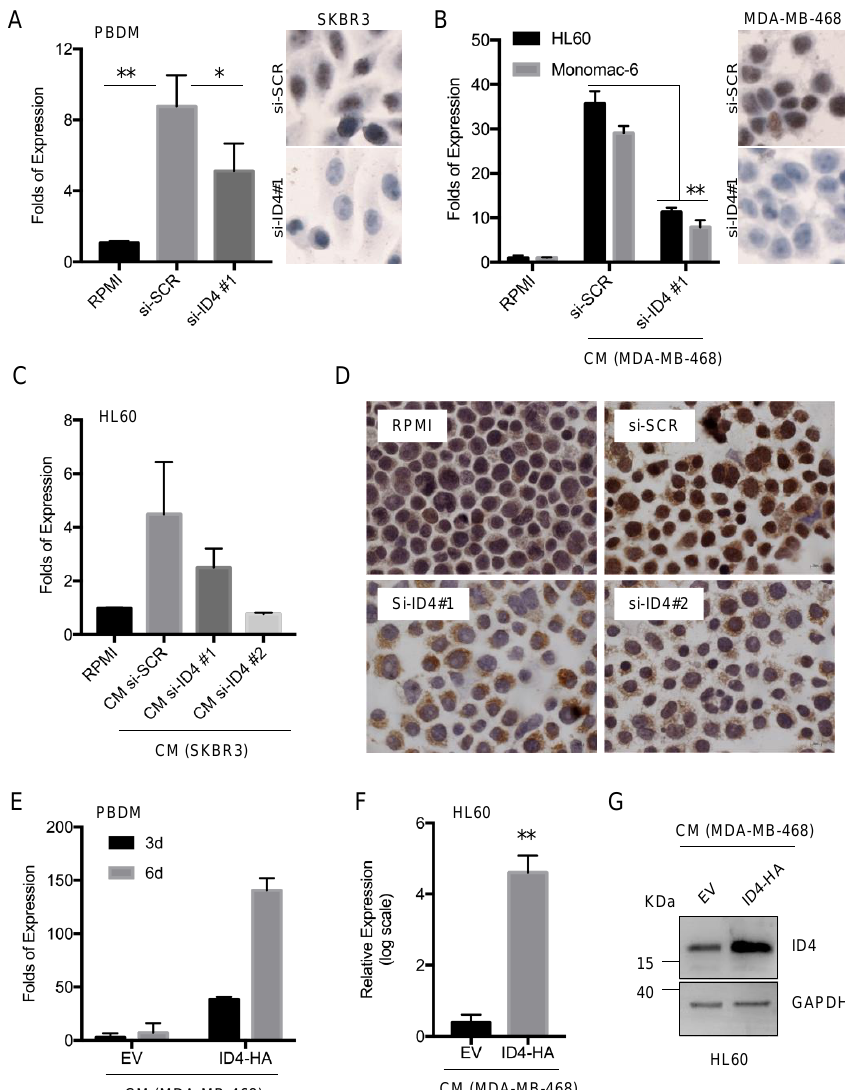
Figure 2. Dependency between ID4 expression levels in BC cells and TAMs. ( A ) ID4 mRNA expression in macrophages derived from PBDM co-cultured with control (si-SCR) or ID4-depleted (si-ID4) SKBR3 cells for 48 h. Right panels show ID4 protein levels, evaluated by immunocytochemistry, in control (si-SCR) and ID4-depleted (si-ID4#1) SKBR3 cells used for the co-culture. ( B ) ID4 mRNA expression in di ff erentiated HL60 cells and in monomac-6 cells cultured with RPMI medium or with CM from the control (si-SCR) or ID4-depleted (si-ID4) MDA-MB-468 cells. Right panels show ID4 protein levels, evaluated by immunocytochemistry, in the control (si-SCR) and ID4-depleted (si-ID4#1) MDA-MB-468 cells used for the preparation of CM. ( C , D ) ID4 mRNA ( C ) and protein ( D ) expression evaluated by RT-qPCR and immunocytochemistry, respectively, in di ff erentiated HL60 cells cultured with RPMI medium or with CM from control (si-SCR) or ID4-depleted (si-ID4#1 and si-ID4#2) SKBR3 cells. ( E ) ID4 mRNA expression on PBDM cultured with CM from control (EV) and ID4-HA-overexpressing MDA-MB-468 cells for the indicated number of days. F-G. ID4 mRNA ( F ) and protein ( G ) expression evaluated on macrophages obtained from HL60 di ff erentiation and cultured in CM from control (EV) or ID4-HA-overexpressing (ID4-HA) MDA-MB-468 cells. * ( p < 0.05), ** ( p < 0.005). P-values were calculated by a paired two-tailed t-test.